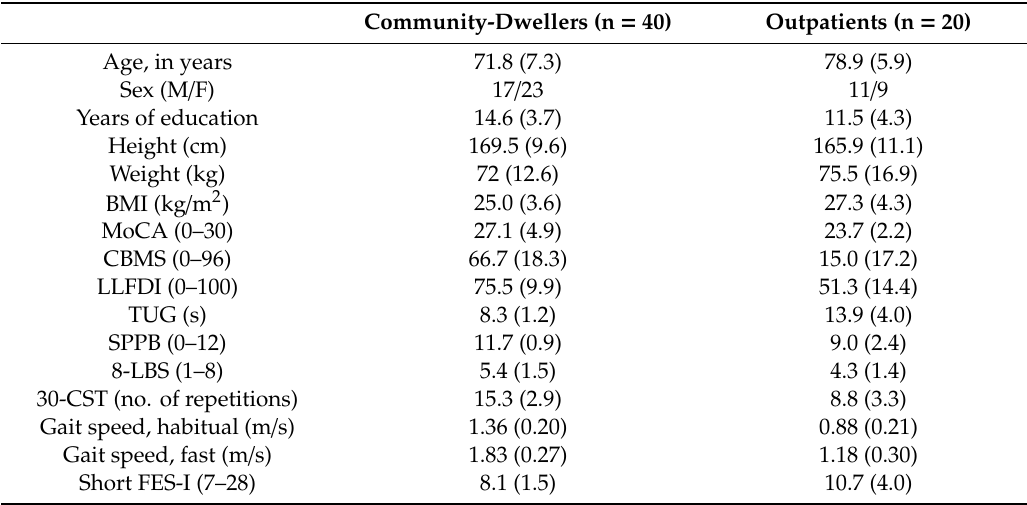
Table 1. Participants’ characteristics. Mean and standard deviation (SD) for all variables except sex distribution.